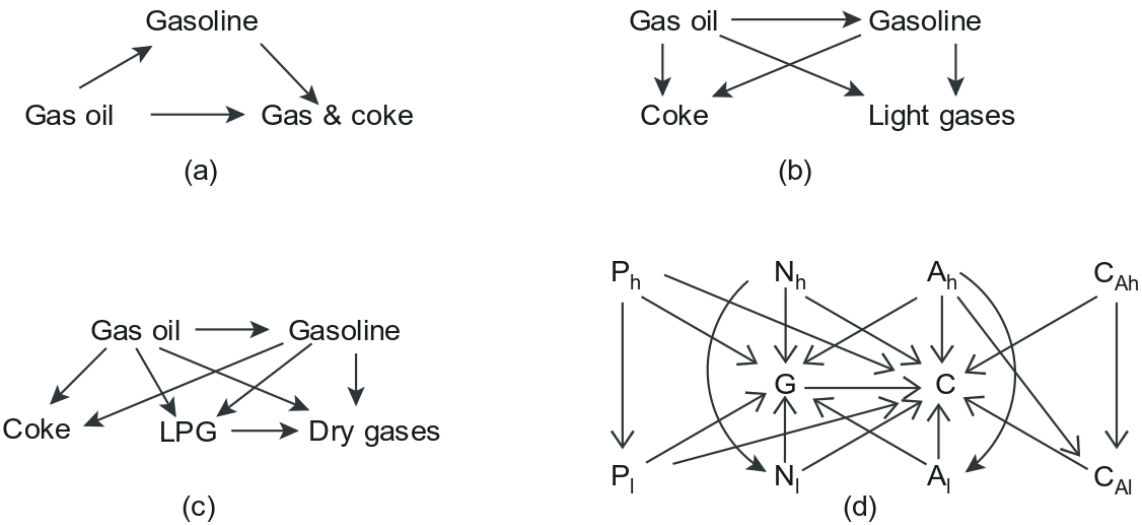
Figure 4. Lumped kinetic models: ( a ) 3-lump model of Weekman and Nace [74], ( b ) 4-lump model of Lee et al. [75], ( c ) 5-lump model of Ancheyta-juarez et al. [80], and ( d ) 10-lump model of Jacob et al. [17] ( P h ,N h ,A h ,C Ah for heavy fraction paraffins, naphthenics, aromatic substitutes and aromatic rings respectively, and P l ,N l ,A l ,C Al for light fraction paraffins, naphthenics, aromatic substitutes and aromatic rings respectively, G for gasoline and C for light gases plus coke). Table 4. Some kinetic parameters of discrete lumping models. 4—Lump Parameters of Ancheyta-Juarez